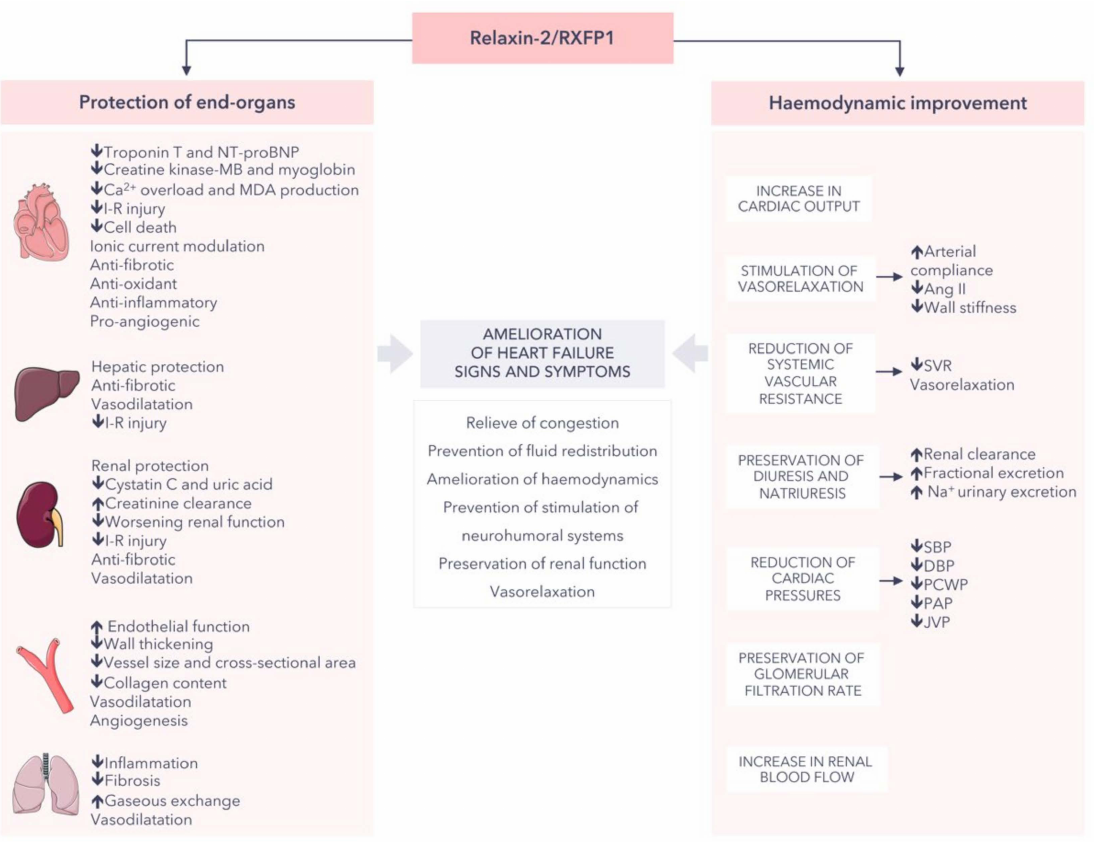
Figure 2. Effects mediated by relaxin-2 (or serelaxin) that counteract end-organ damage and improve haemodynamic imbalance during heart failure [12,15,33,95]. Ang II: angiotensin II. DBP: dias- tolic blood pressure. I-R: ischemia-reperfusion. MDA: malondialdehyde. NT-proBNP: N-terminal pro-B-type natriuretic peptide. PAP: pulmonary artery pressure. JVP: jugular venous pressure. PCWP: pulmonary capillary wedge pressure. SBP: systolic blood pressure. SVR: systemic vascular resistance. Parts of the figure were drawn by using pictures from Servier Medical Art. Servier Medical Art by Servier is licensed under a Creative Commons Attribution 3.0 Unported License (https://creativecommons.org/licenses/by/3.0/ (accessed on 1 May